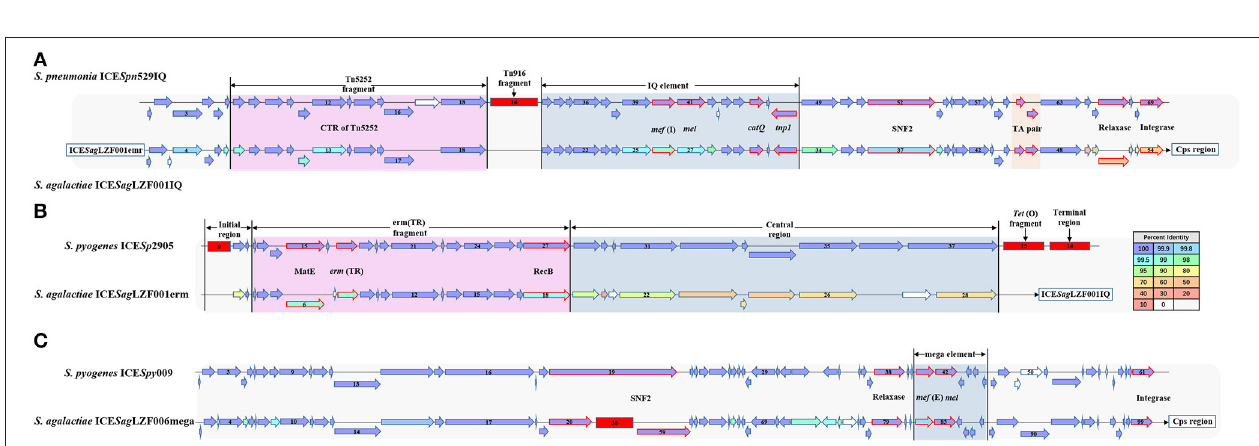
FIGURE 3 | The evolutionary analysis of homologous proteins in cps operon and their structure. (A) A Maximum Likelihood phylogenetic tree based on 12 single copy orthology clusters of cps operon from 20 strains. The bootstrap confidence value which was 100 was not shown in the figure. (B) The cps operon structure of GBS serotypes Ia, Ib, III, and V. The cpsY , cpsA-cpsL , NeuA-NeuD genes were labeled with arrows, and the arrow showed the direction of transcription. The different color of arrow indicated the percent identity of the encoded protein.